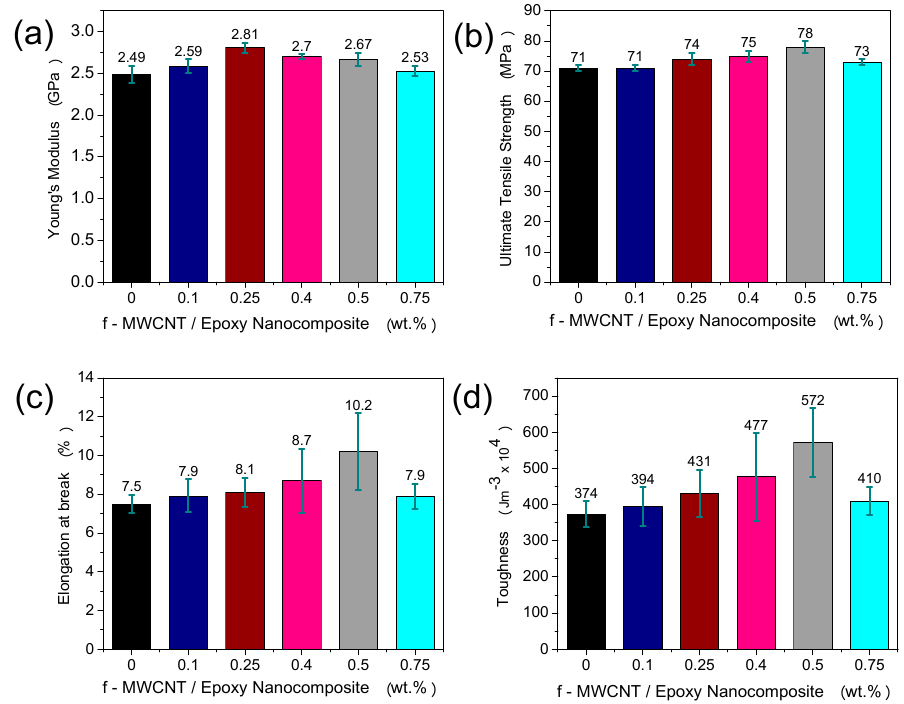
Figure 2. ( a ) Young’s modulus; ( b ) ultimate tensile strength (UTS); ( c ) elongation at break (%), and ( d ) toughness obtained from stress-strain curve of neat epoxy and f-MWCNT/Epoxy nanocomposites. In all cases, error bars indicate standard deviation. Table 1. Variation of E, UTS, % EL and T for different f-MWCNT loading relative to the neat epoxy.